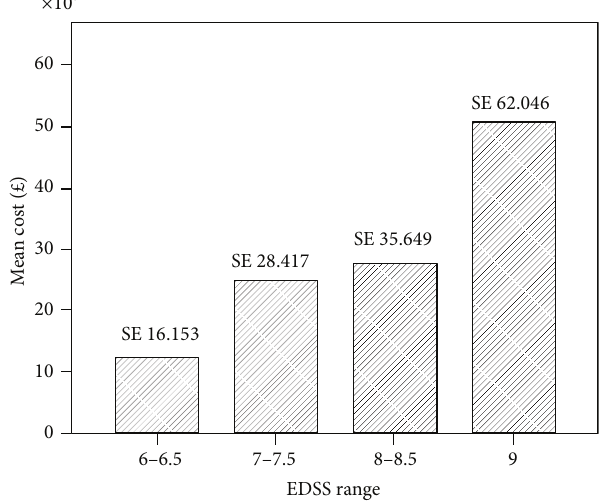
Figure 1: Mean cost and standard errors (SE) in each EDSS group for sample 𝑛 = 86 .